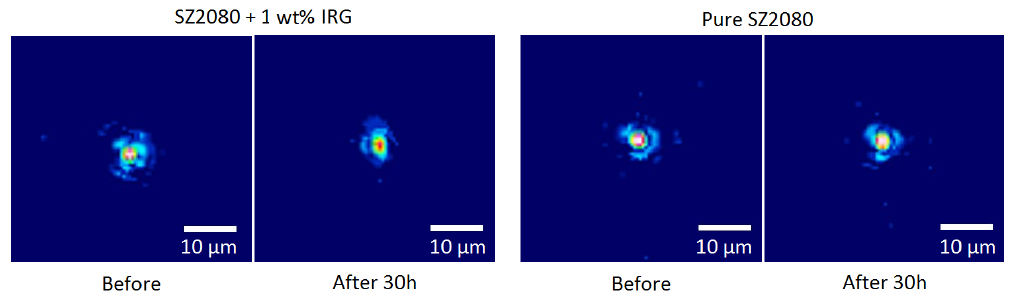
Figure 5. Images of the focal plane of a microlens before and after 30 h of exposure to 405 nm CW laser radiation. No significant change in the image at the focal point can be discerned.